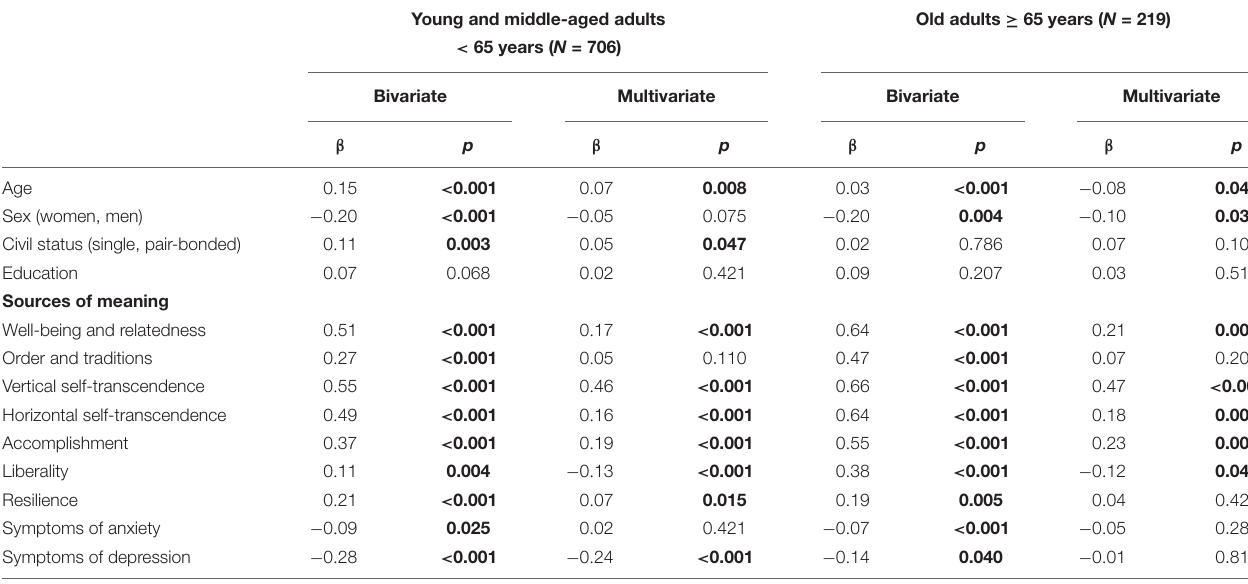
TABLE 2 | Bivariate and multivariate linear regression of the associations between demographics, anxiety, depression, sources of meaning, resilience, and meaningfulness (dependent variable).